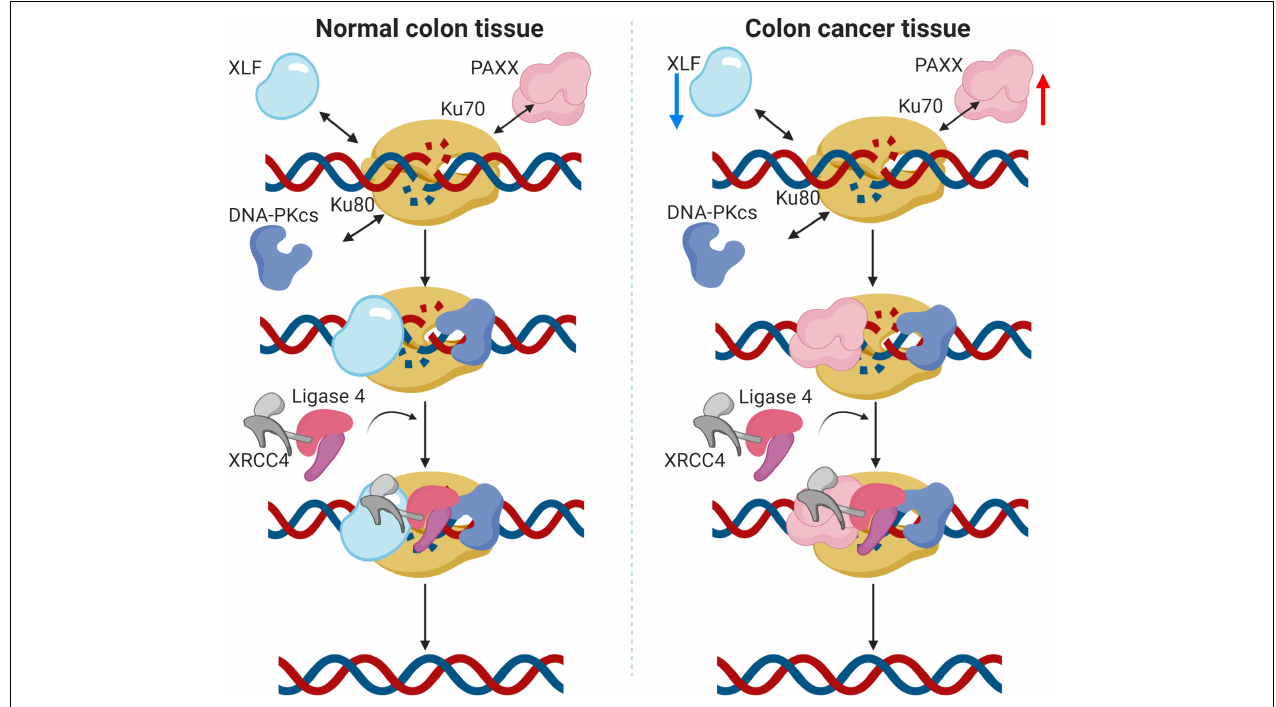
FIGURE 9 | Graphical representation of the proposed function of PAXX in the NHEJ pathway in colon cancer. In normal colon tissues ( left panel), DNA double strand breaks (DSBs) are actively identified by Ku70 and Ku80, followed by the recruitment of DNA-PKcs. The Ku/DNA-PKcs complex phosphorylates and recruits other accessory factors for DNA end processing. XRCC4 and XLF also bind to the DSB site and recruit DNA Ligase IV, which eventually seals the DSBs. PAXX has been demonstrated to work in the absence of XLF, as a backup in c-NHEJ repair (Tadi et al., 2016). In the case of colon cancer ( right panel), protein levels of these proteins are altered. Notably, XLF is downregulated and PAXX is upregulated, suggesting PAXX may preferentially take over the XLF functions in colon cancer cells.